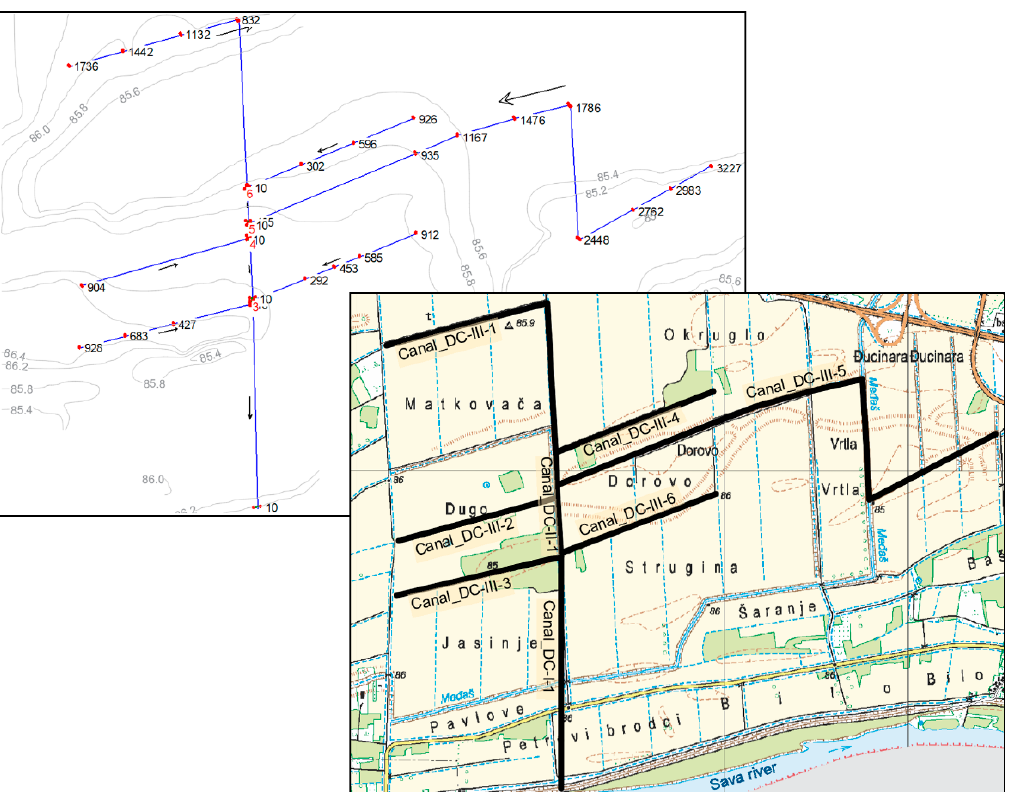
Figure 7. Scheme of the existing drainage canal network: HEC-RAS model geometry ( left ); topographic map ( right ).